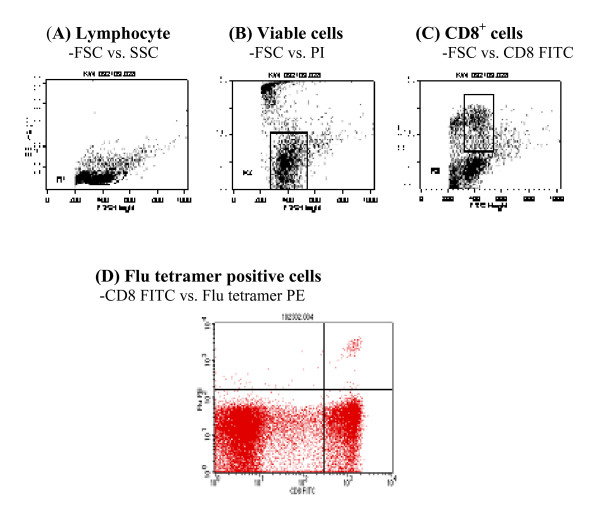
Detection of tetramer positive cells among PBMC. Gating sequence is shown in the upper panel. (A) R1-Lymphocyte gate, FSC (x-axis) vs. SSC (y-axis). (B) R2-Viable cell gate, FSC (x-axis) vs. PI (y-axis). (C) R3-CD8+ cell gate, FSC (x-axis) vs. CD8 FITC (y-axis). Flu-tetramer positive cells are shown in (D) Flu tetramer positive cells, CD8 FITC (x-axis) vs. Flu tetramer PE (y-axis), gated on R1 and R2 for viable lymphocyte. CD8 negative cells are shown (with R3 off), demonstrating assay specificity.